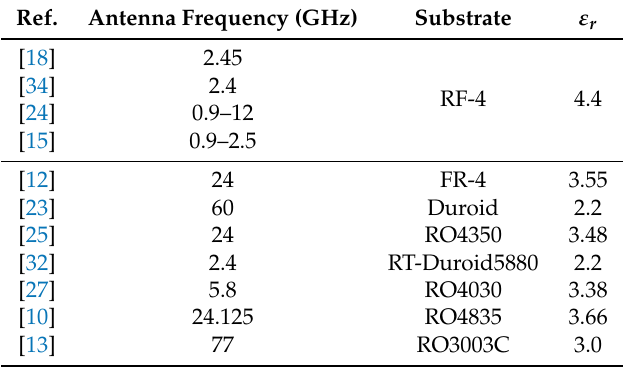
Table 3. Summary of the materials used as a dielectric substrate for bio-radar antennas.